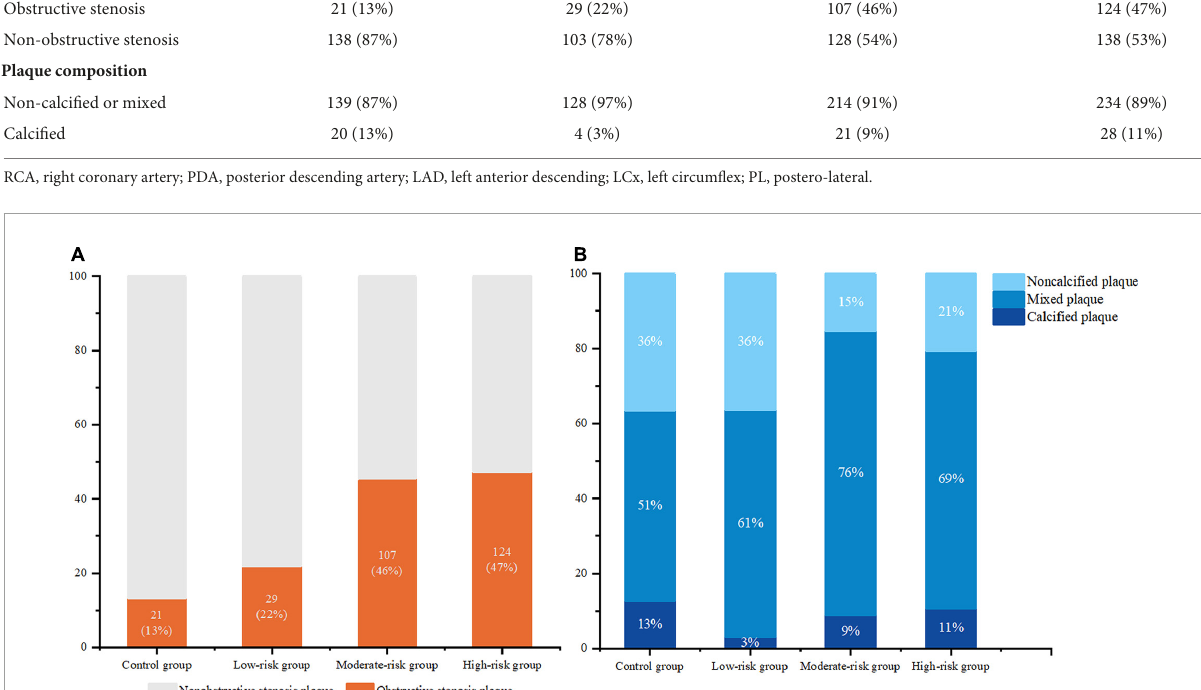
The SSS in the moderate-risk group [5.5 (3.0, 10.0)] and the high-risk group [5.0 (3.0, 12.5)] were significantly higher than that in the control group [1.0 (0.0, 4.3)] ( p < 0.001, p < 0.001,